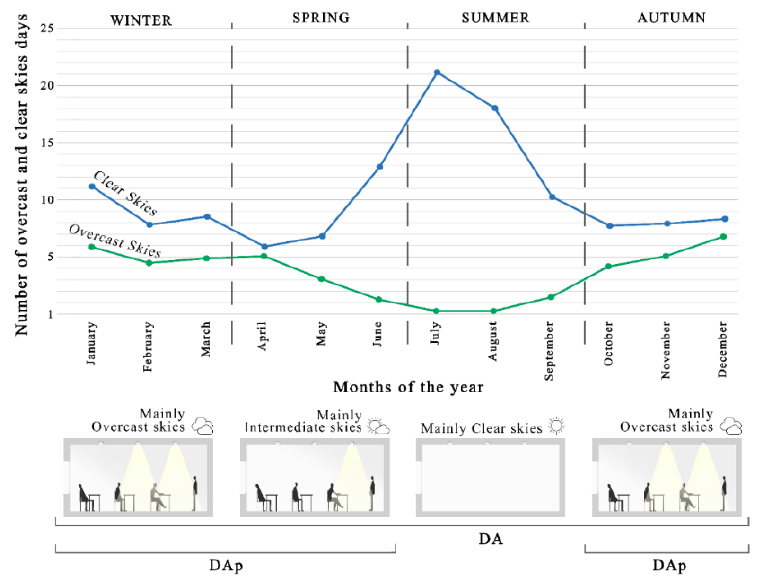
Figure 1. Graphical representation of DA and DAp for a seasonal use space (example of space located in Madrid, Spain, with mainly clear skies).